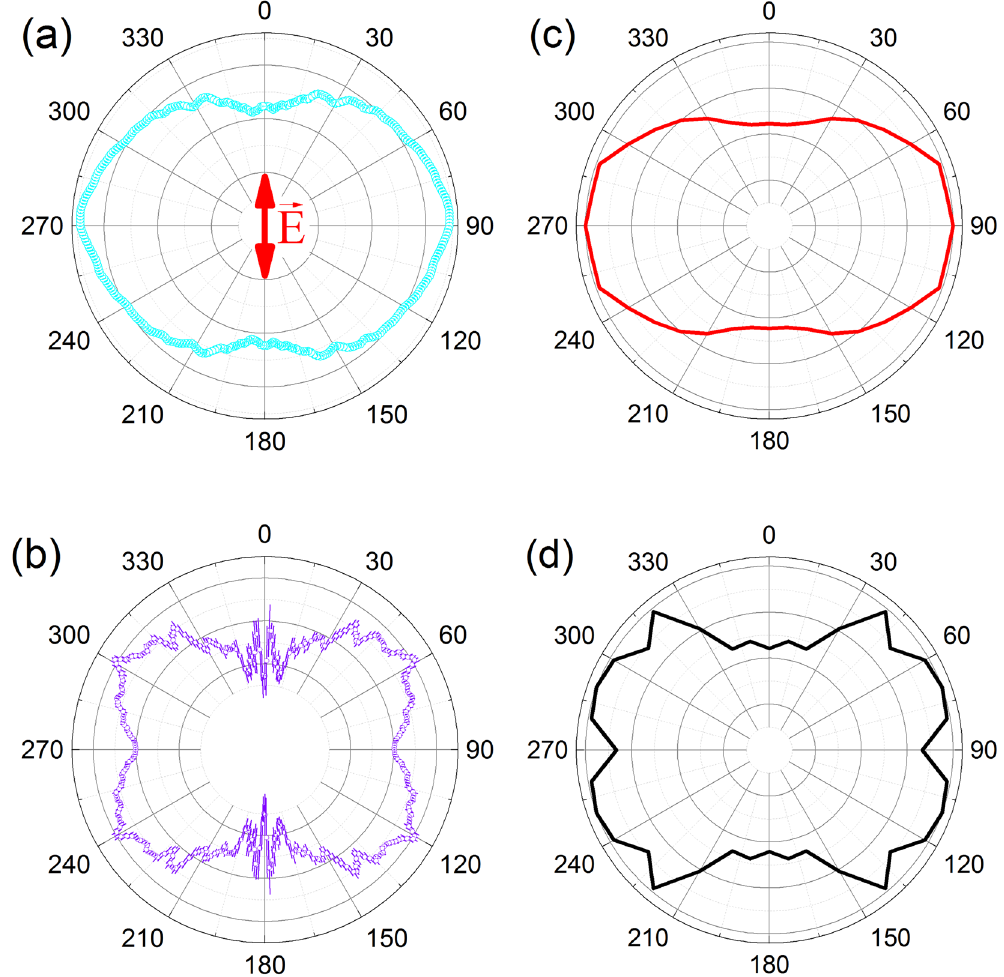
Figure 3. ( a ) Measured C 2 D 5 + photofragment angular distribution from the n ω + C 2 D 6 → C 2 D 6 + → C 2 D 5 + + D process at I peak = 2 × 10 15 W cm − 2 (I avg = 2 × 10 13 W cm − 2 ) and a pulse duration of about 5 fs. ( b ) Measured C 2 D 5 + photofragment angular distribution for the same process and pulse duration but at a higher intensity: I peak = 7 × 10 15 W cm − 2 and I avg = 6 × 10 13 W cm − 2 . ( c ) Calculated C 2 D 5 + angular distribution without including FDRC orbitals, at a uniform intensity of 9 × 10 13 W cm − 2 . ( d ) Calculated C 2 D 5 + angular distribution once the FDRC orbitals are included, at a uniform intensity of 2 × 10 15 W cm − 2 . The laser polarization, indicated by the red arrow in ( a ), is vertical in all panels. The ethane HOMO has π *